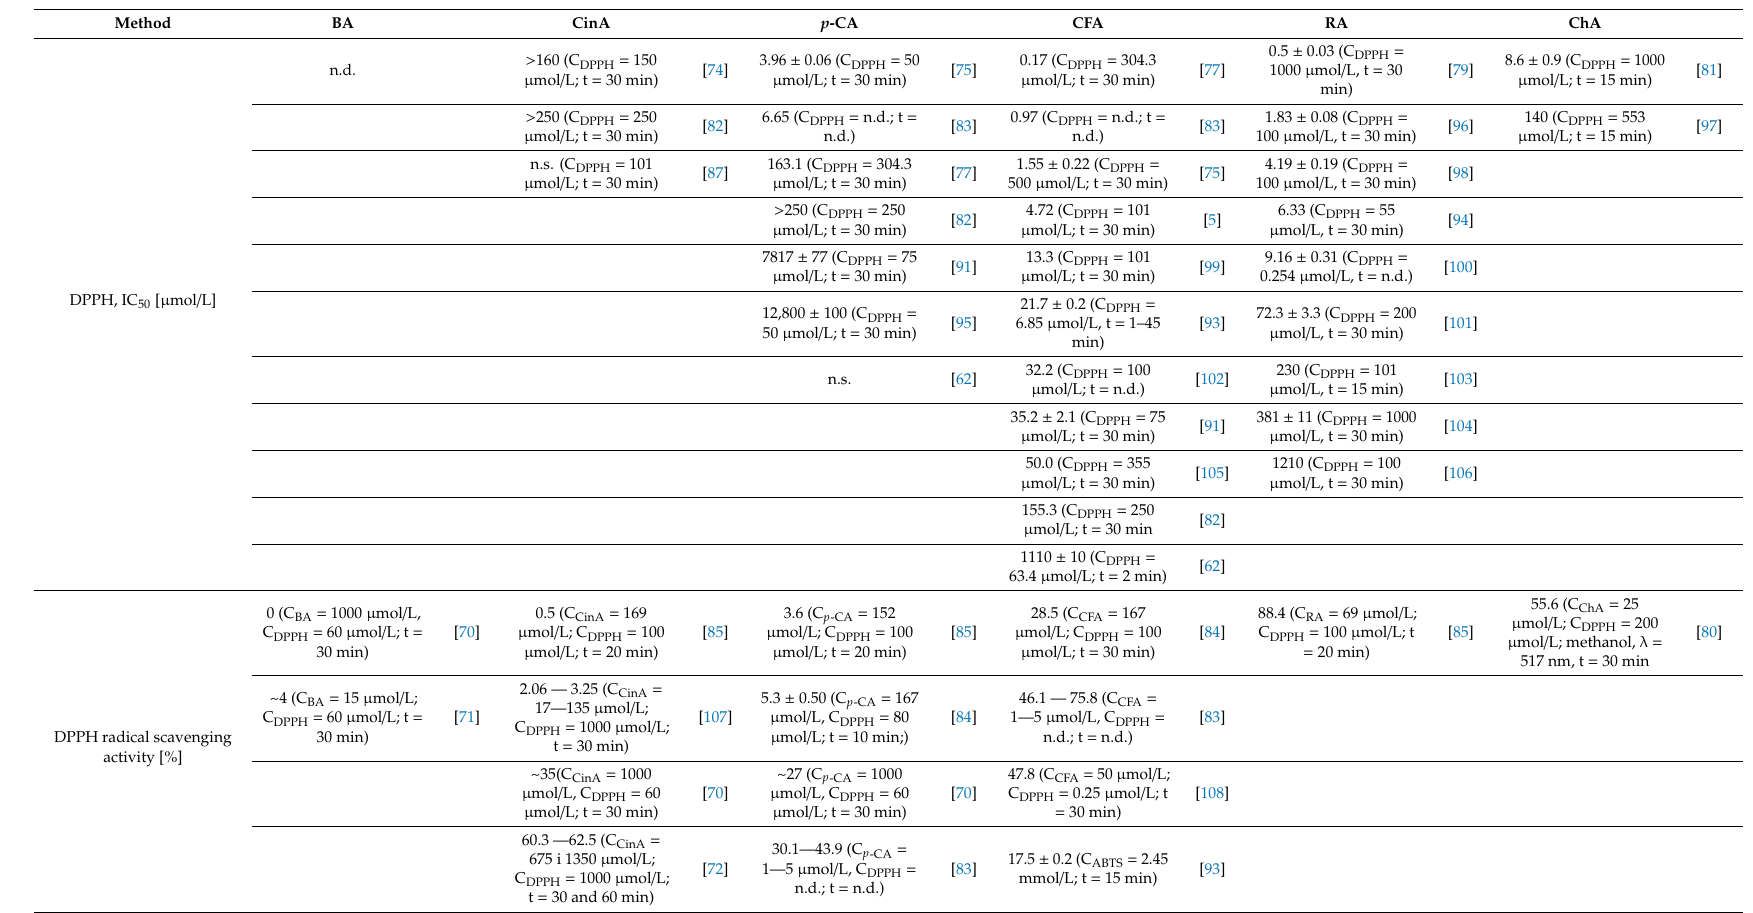
Table 3. Antioxidant activity of